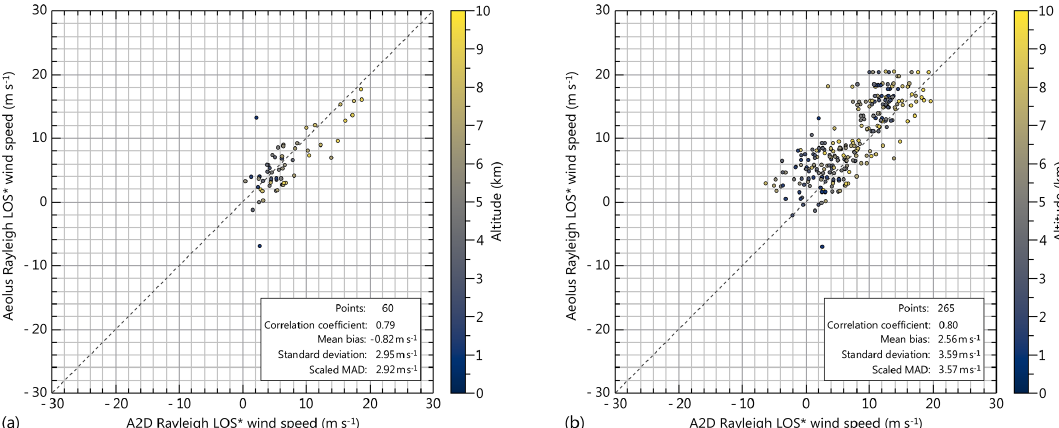
Figure 12. Scatterplots comparing the Aeolus L2B Rayleigh LOS* winds with the A2D Rayleigh LOS* winds (a) for the wind scene on 22 November 2018 between 16:13 and 17:15UTC and (b) for all of the underflights from the WindVal III campaign. The data points are colour-coded with respect to the bottom altitude of the respective bins used for